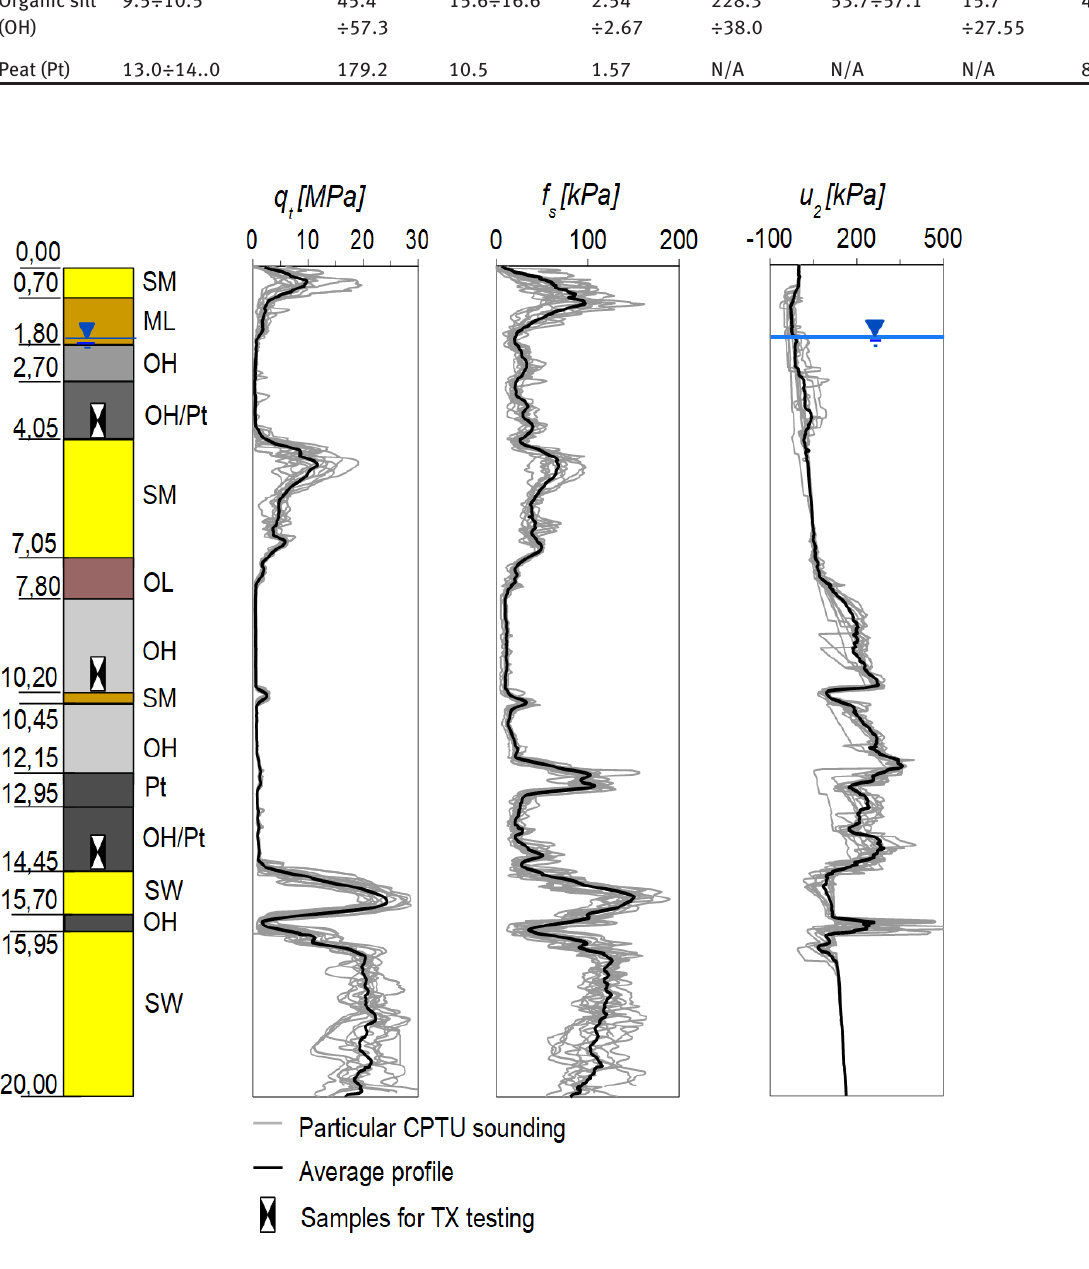
Figure 1: Soil profile and CPTU sounding